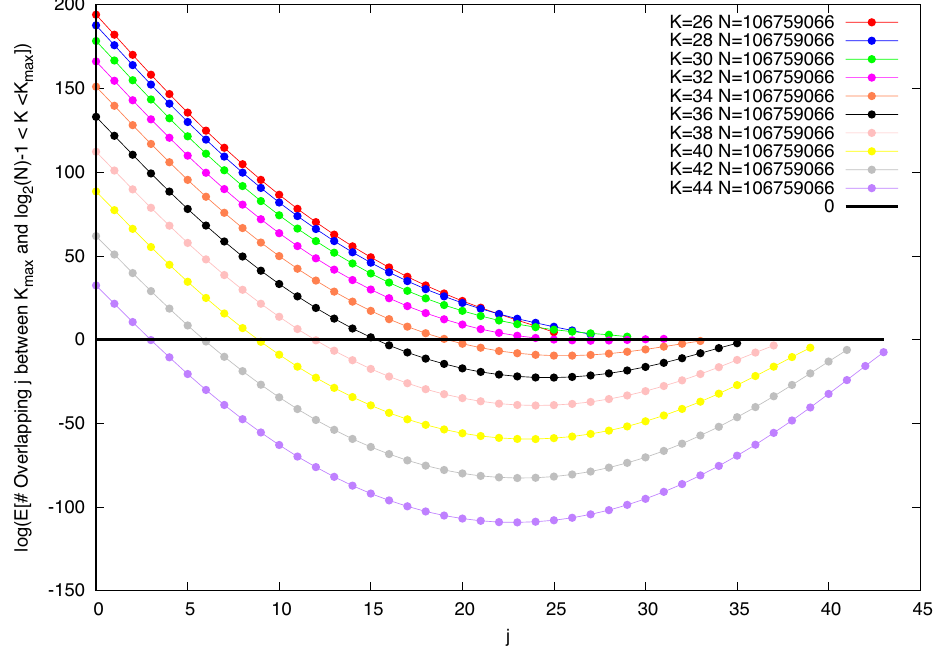
Figure 8. Expected number of overlaps between a single clique of size k < K max and all other cliques of the same size versus j , the amount of sites common to the two cliques. For this extreme value of N = 106759066 , we are at the start of the step in which K max becomes 46, while log 2 N is 26.7. A gap has opened at K larger values of K , overlaps rapidly shrink. Cliques with K